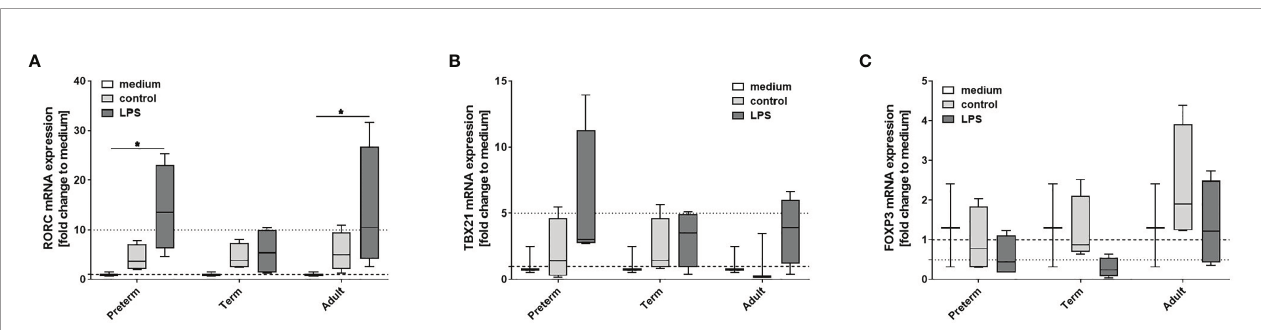
FIGURE 4 | Neonatal CD4+ T cell polarization by LPS-stimulated macrophage (M Ф ) supernatants. Neonatal CD4+ T cells were incubated for 6 days with supernatants of LPS-stimulated preterm, term or adult M Ф collected after incubation for 72 h (48 h 21% O 2 followed by 24 h at 21% O 2 with or without LPS). mRNA was assessed using RT qPCR. Box plots of RORC (A) , TBX21 (B) and FOXP3 (C) mRNA expression normalized to b -Actin depicted as a fold change to the medium control. The dotted line at 1 indicates the normalization level and the second dotted line is an auxiliary line to aid with visualization (n=4 independent 72 h supernatants were used (same as Figure 2 ) on neonatal CD4+ cells isolated from one donor, box plots: median ± 25 th to 75 th percentiles and minimum to maximum, ANOVA followed by Holm-Sidak ’ s test, *p<0.05).